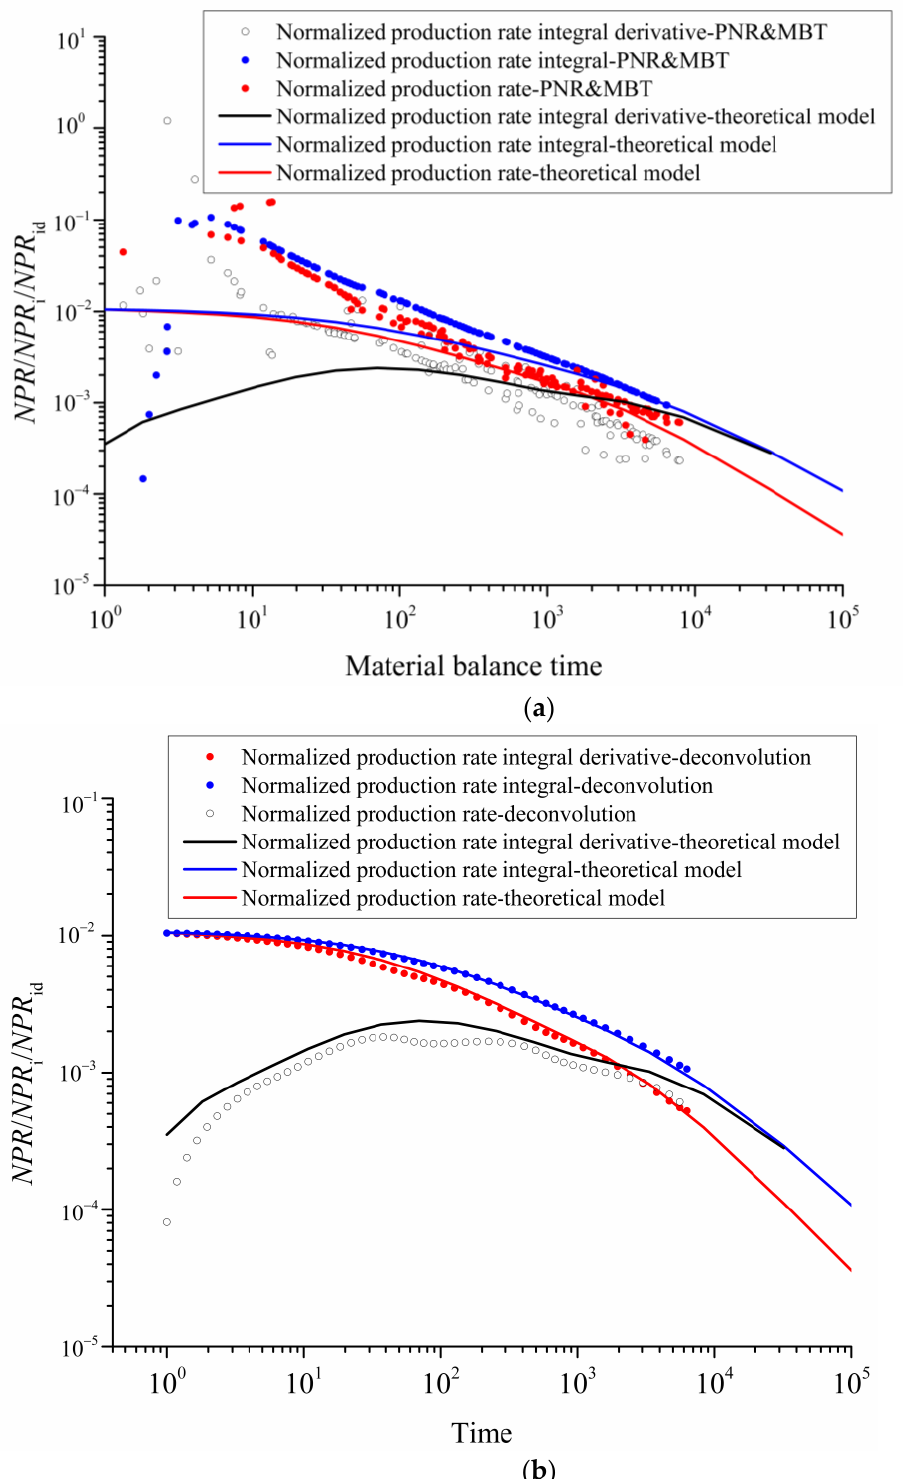
Figure 11. Blasingame production decline typical curve fitting results of the production data processed by two different normalization methods and the seepage theoretical model: ( a ) PNR-MBT method; ( b ) flow rate deconvolution algorithm.